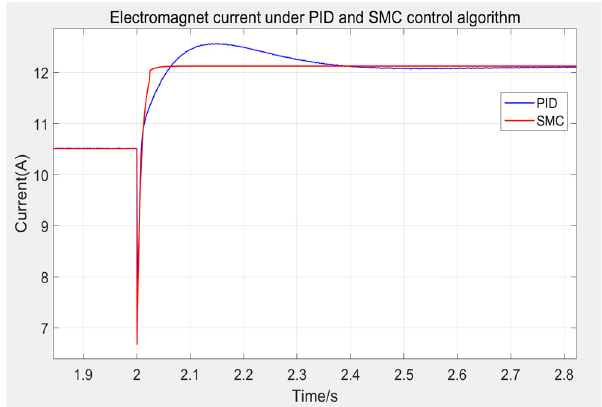
Figure 11. Partial enlarged view of electromagnet current.